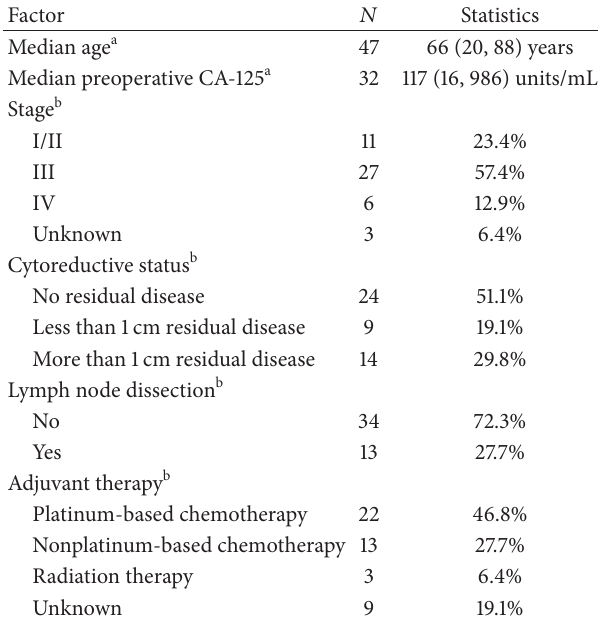
Table 1: Clinicopathologic and treatment characteristics. Statistics are reported in median with ranges and